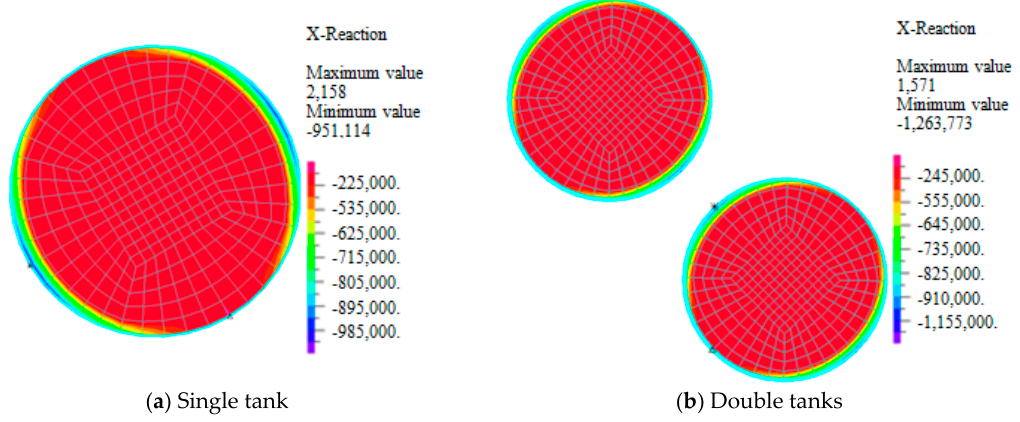
Figure 14. Effect of wind interference on base shear force (unit: N).